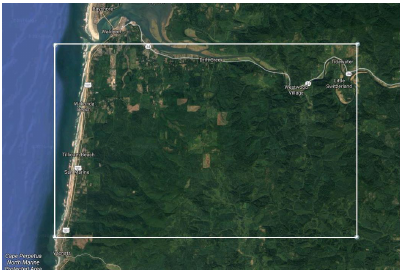
Figure 4. The boxed area under investigation, adapted from Google Earth [21]. It lies within ψ ∈ (44.32 ◦ , 44.42 ◦ ) and θ ∈ ( − 124.11 ◦ , − 123.89 ◦ ).